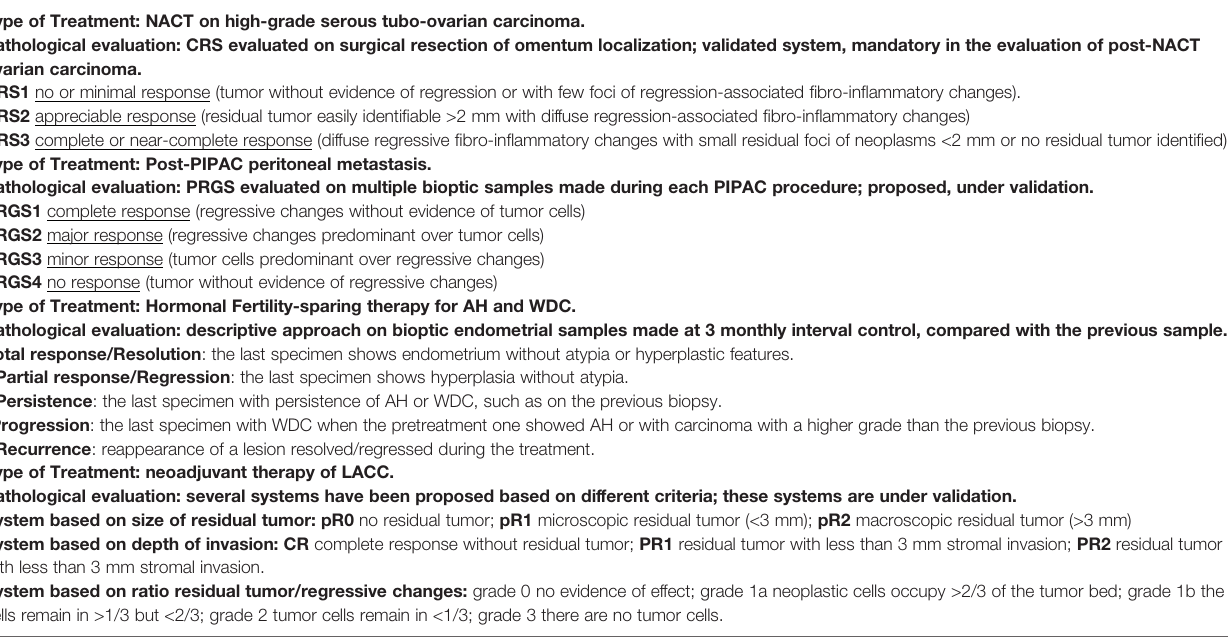
TABLE 1 | Key points on de fi nition of tumor response for main gynecological neoplasms. Type of Treatment: NACT on high-grade serous tubo-ovarian carcinoma. Pathological evaluation: CRS evaluated on surgical resection of omentum localization; validated system, mandatory in the evaluation of post-NACT ovarian carcinoma. CRS1 no or minimal response (tumor without evidence of regression or with few foci of regression-associated fi bro-in fl ammatory changes). CRS2 appreciable response (residual tumor easily identi fi able >2 mm with diffuse regression-associated fi bro-in fl ammatory changes) CRS3 complete or near-complete response (diffuse regressive fi bro-in fl ammatory changes with small residual foci of neoplasms <2 mm or no residual tumor identi fi ed) Type of Treatment: Post-PIPAC peritoneal metastasis. Pathological evaluation: PRGS evaluated on multiple bioptic samples made during each PIPAC procedure; proposed, under